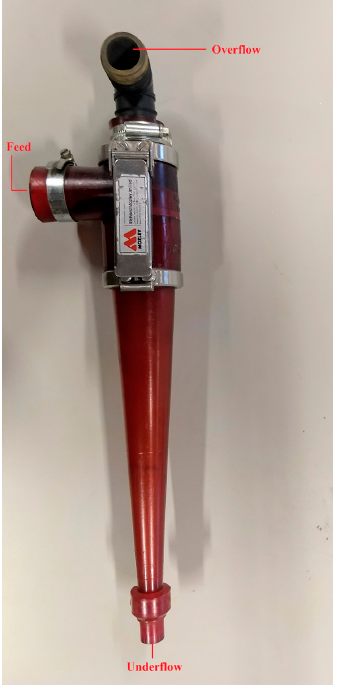
Figure 1. A typical hydrocyclone (Image taken by Malik Degri).